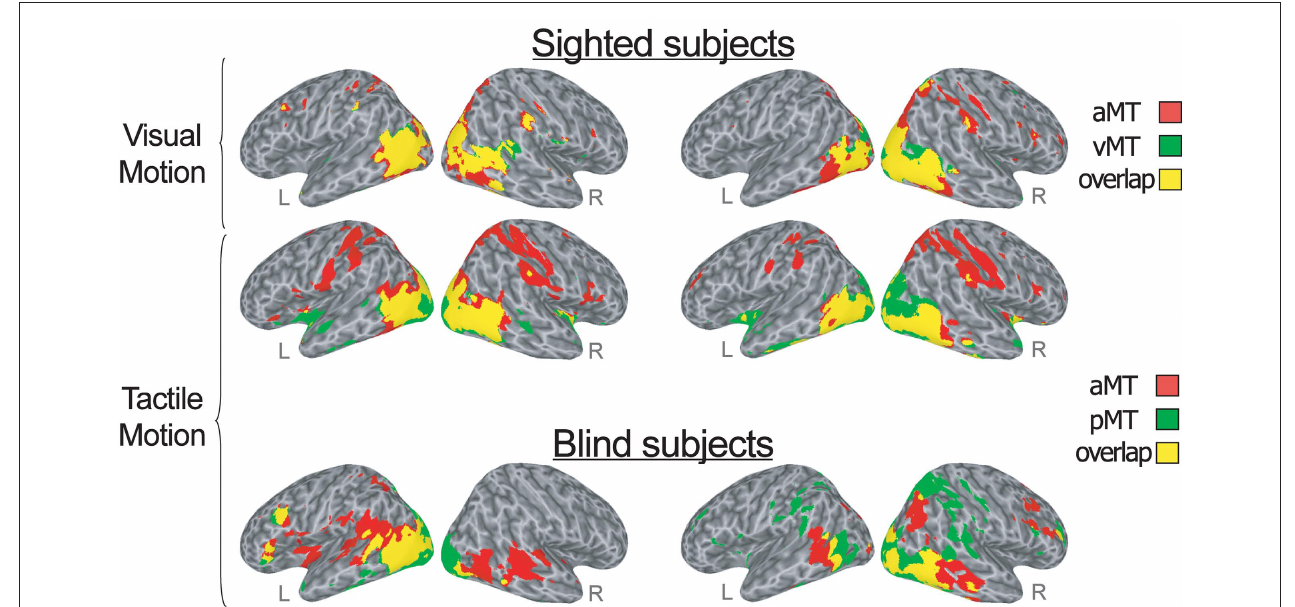
posterior (green) hMT+ seed-ROIs during visual (top row) and tactile (middle row) motion runs in sighted subjects, and during tactile (bottom row) motion runs in congenitally blind subjects. Lateral views of the inflated right and left hemispheres are shown. Right and left sides of the figure show the areas correlated respectively with the right and left hMT +